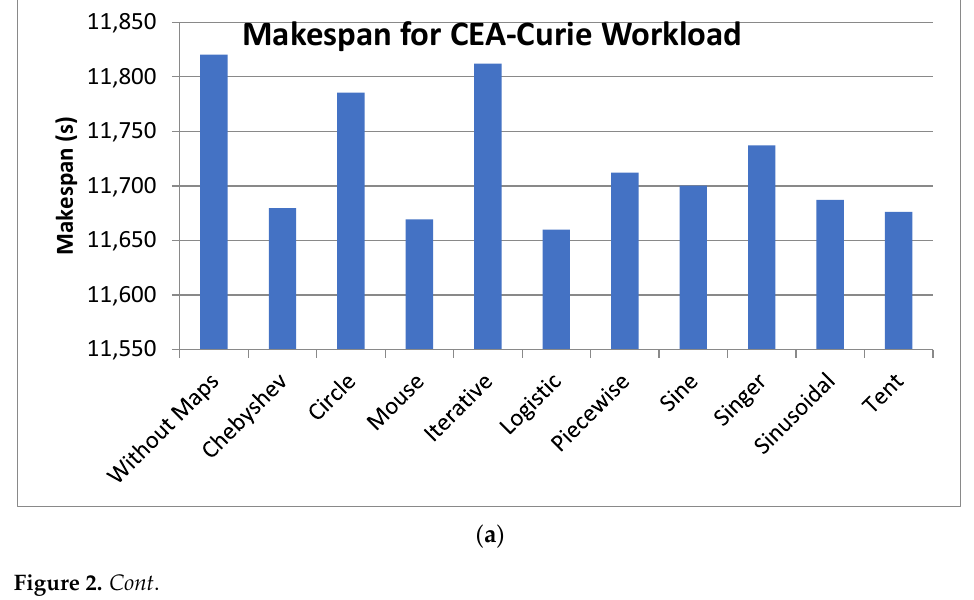
Figure 2. Cont Energy Consumption for CEA-Curie Workload